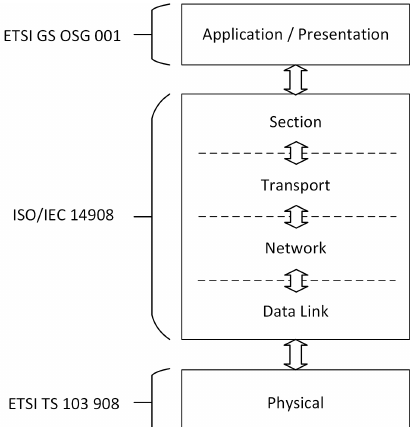
Figure 2. Simplified layered stack of Open Smart Grid Protocol (OSGP) (adapted from [27]).